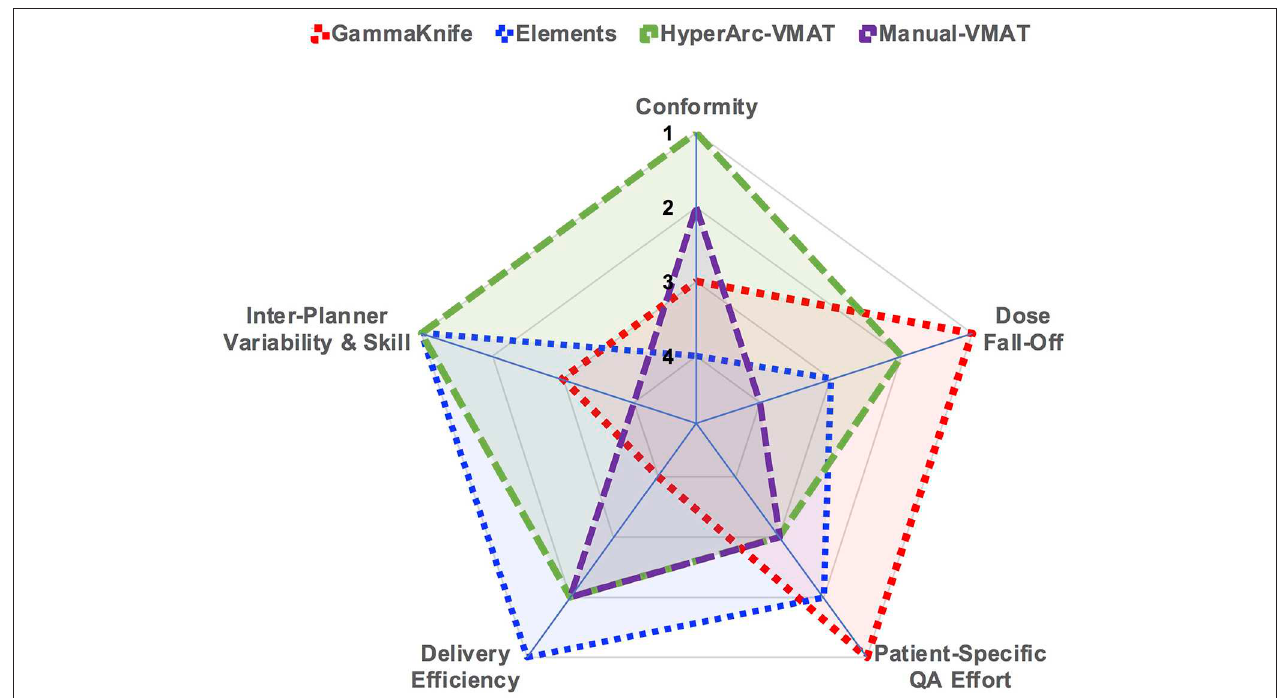
FIGURE 6 | Spider plot graphically comparing the studied SRS techniques across the different categories of dosimetry and efficiency. SRS treatment modalities were ranked relative to each other per specified category on a scale of 1 through 4.